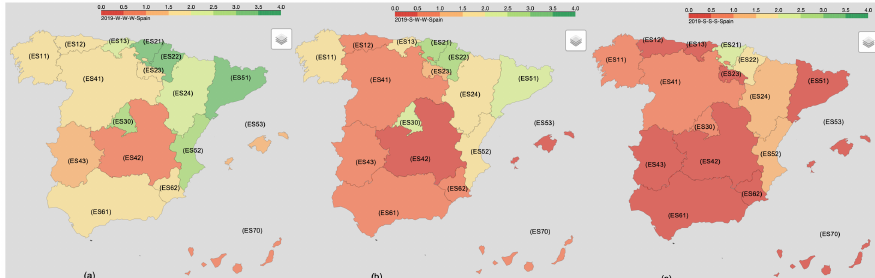
Figure 9. 2019 Innovation Performance of Spanish regions for different compensation degrees with respect to Spanish Reference Levels. ( a ) W-W-W Composite Indicator. ( b ) S-W-W Composite Indicator. ( c ) S-S-S Composite